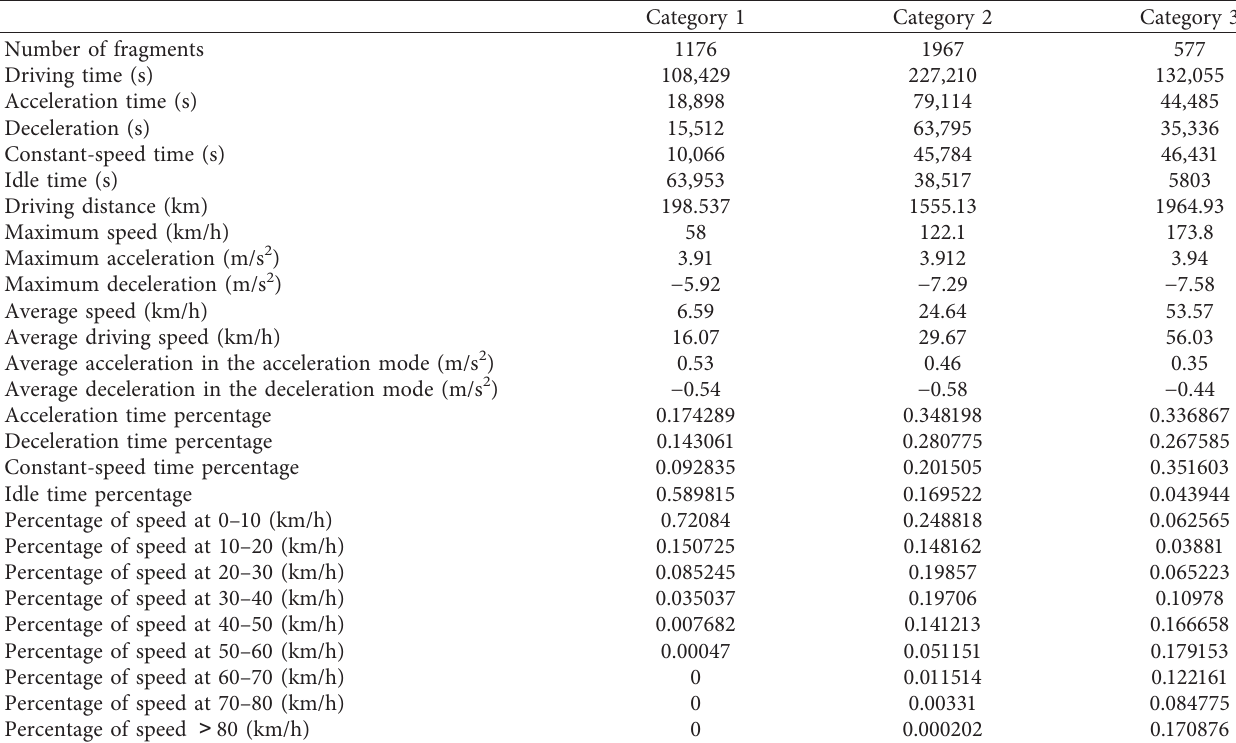
Table 8: Composite feature parameters of fragments in three